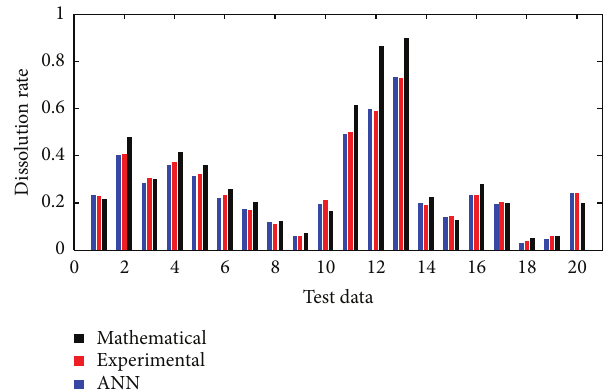
Figure 9: Comparison experimental, mathematical, and ANN for test